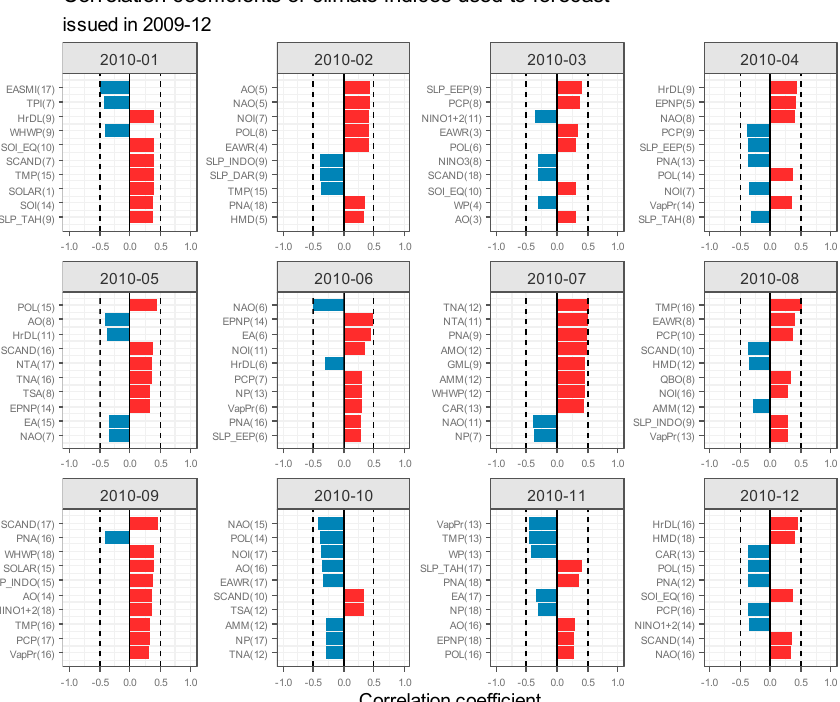
Figure 4. Correlations of the climate indices used for monthly forecasting models from January to December 2010.